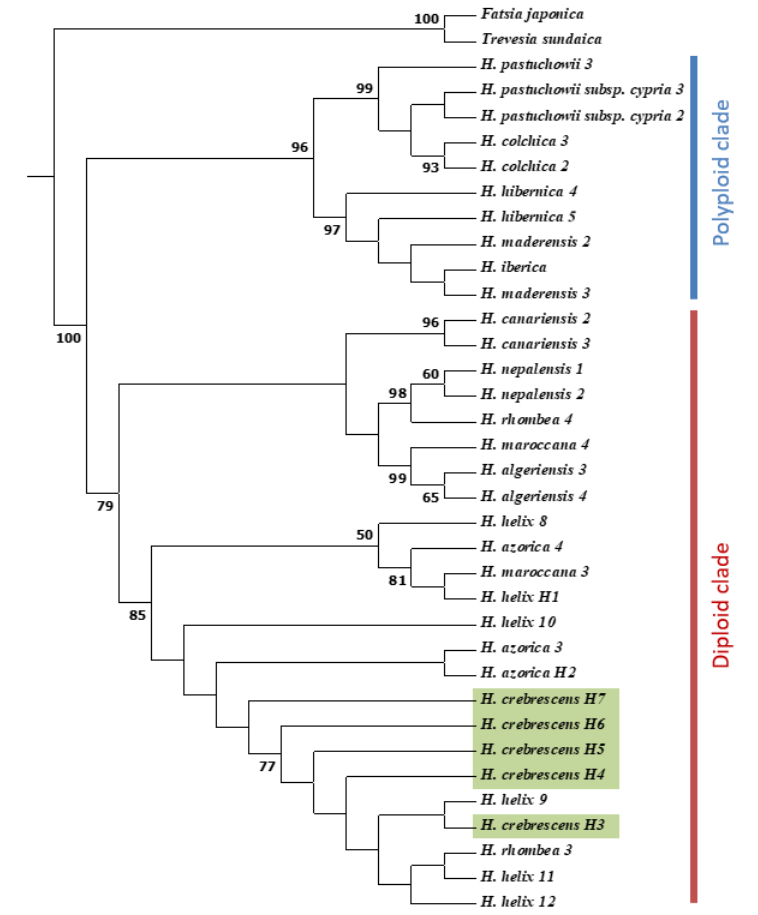
Figure 4 A consensus tree of the nrDNA ITS sequences generated using the maximum likelihood method. Numbers above branches show the bootstrap values from 200 replications (bootstrap values less than 50% are not